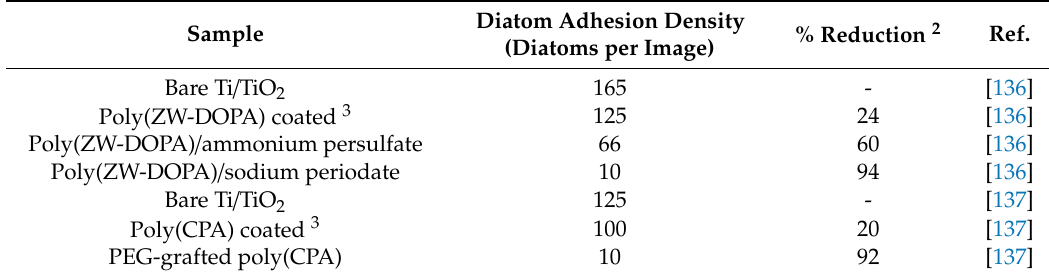
Table 2. Antifouling performance of poly(ZW-DOPA) and poly(CPA) coatings on Ti / TiO 2 against Amphora co ff eaeformis [136,137] 1